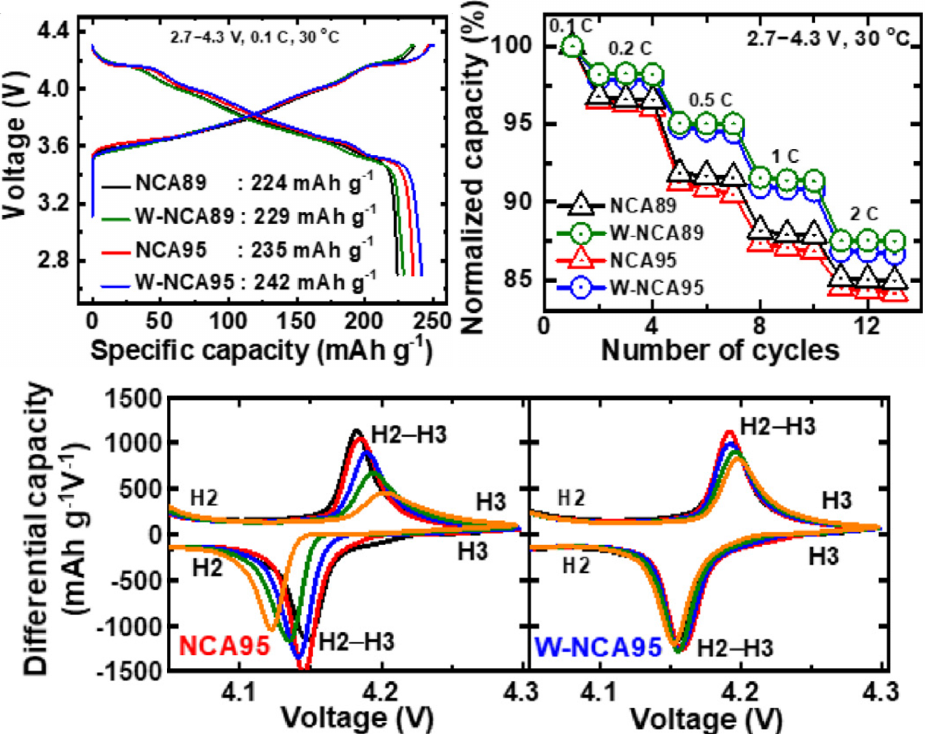
Figure 14. Electrochemical curves for pristine and W doped cathodes: ( Top ) Charge/discharge curves and rate capac- ity for Ni 0.95 Co 0.04 Al 0.01 and Ni 0.885 Co 0.1 Al 0.015 , ( Bottom ) cyclic voltammetry for Ni 0.95 Co 0.04 Al 0.01 . Reproduced with permission